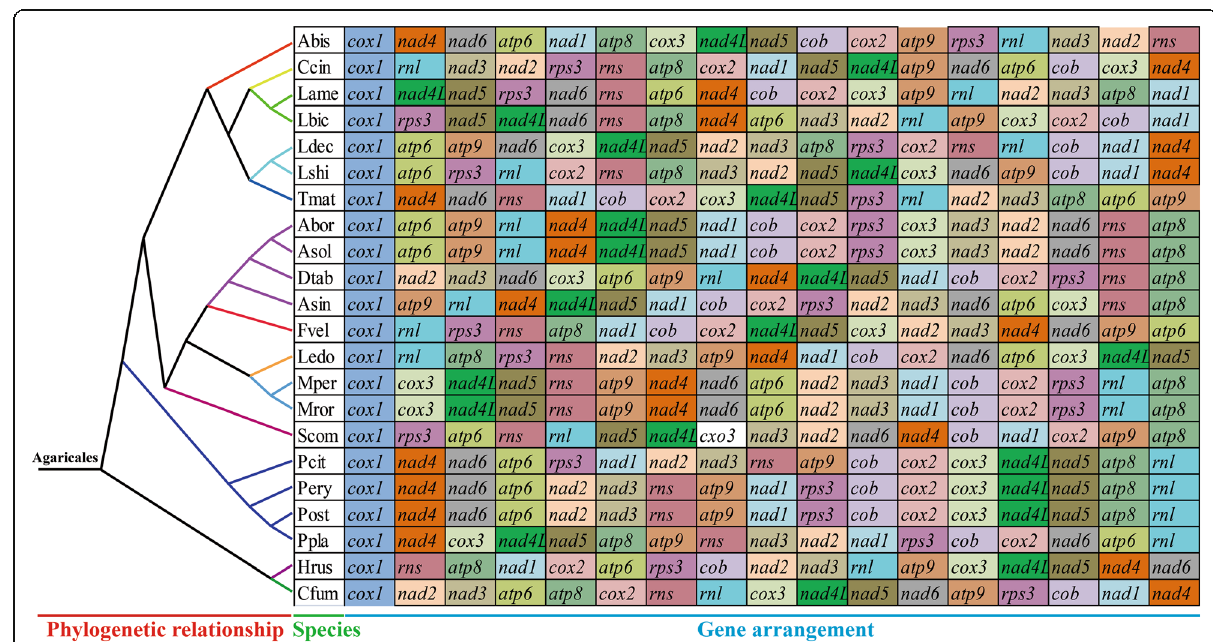
Fig. 6 Mitochondrial gene arrangement analyses of 22 Agaricales species. All genes are shown in order of occurrence in the mitochondrial genome, starting from cox1 . Fifteen core protein coding genes and two rRNA genes were included in the gene arrangement analysis. The phylogenetic positions of 22 Agaricales species were established using the Bayesian inference (BI) method and Maximum Likelihood (ML) method based on concatenated mitochondrial genes. Species and NCBI accession number used for gene arrangement analysis in the present study are listed in Supplementary Table